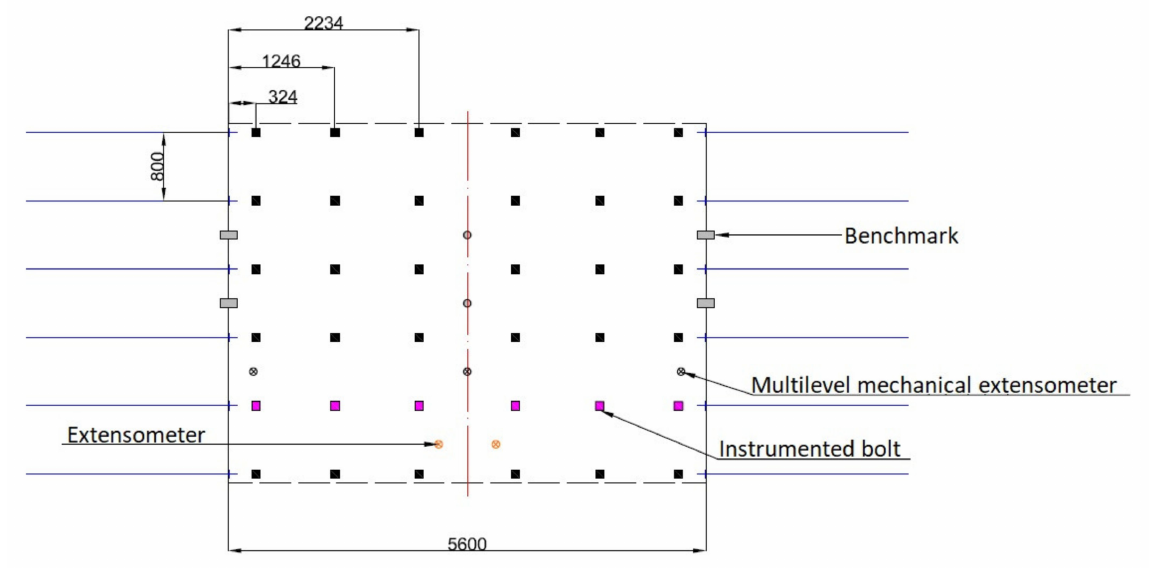
Figure 2. A scheme of periodic control station no. 2 top